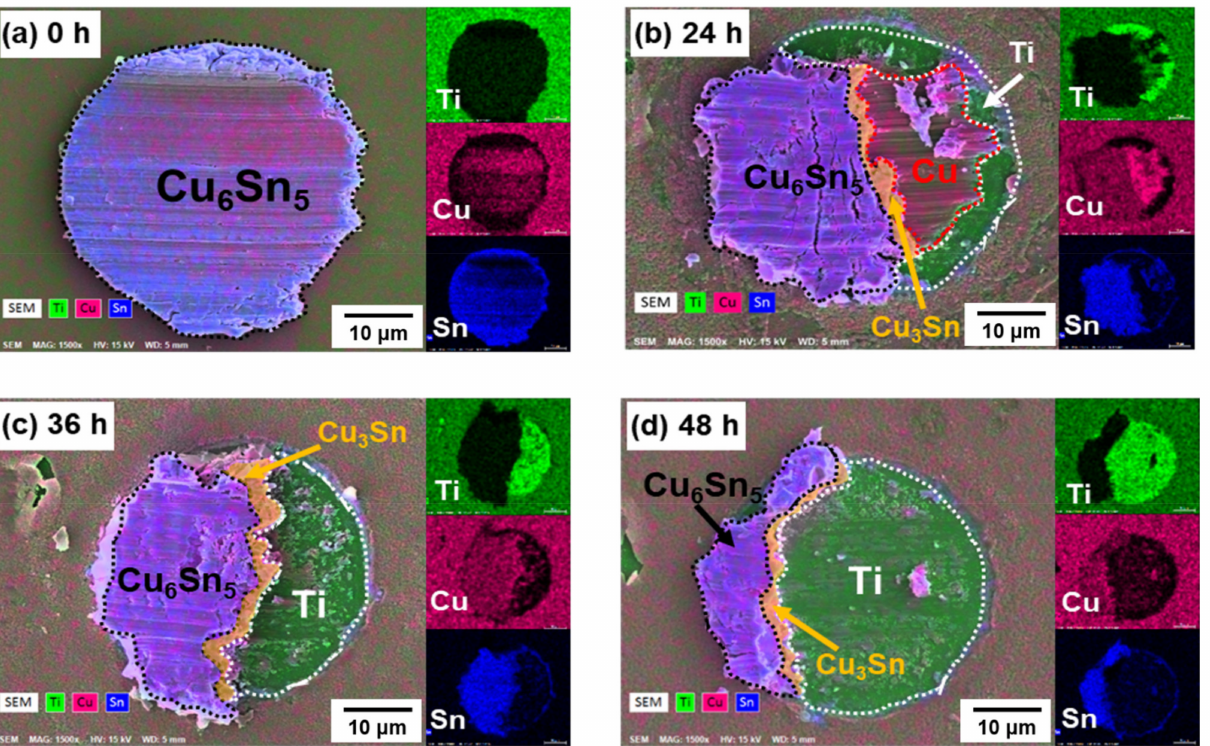
Figure 10. The fracture surfaces of solder joints after aging at 200 ◦ C for: ( a ) 0 h, ( b ) 24 h, ( c ) 36 h and ( d ) 48 h with their elemental area distribution of Ti (green), Cu (red), Sn